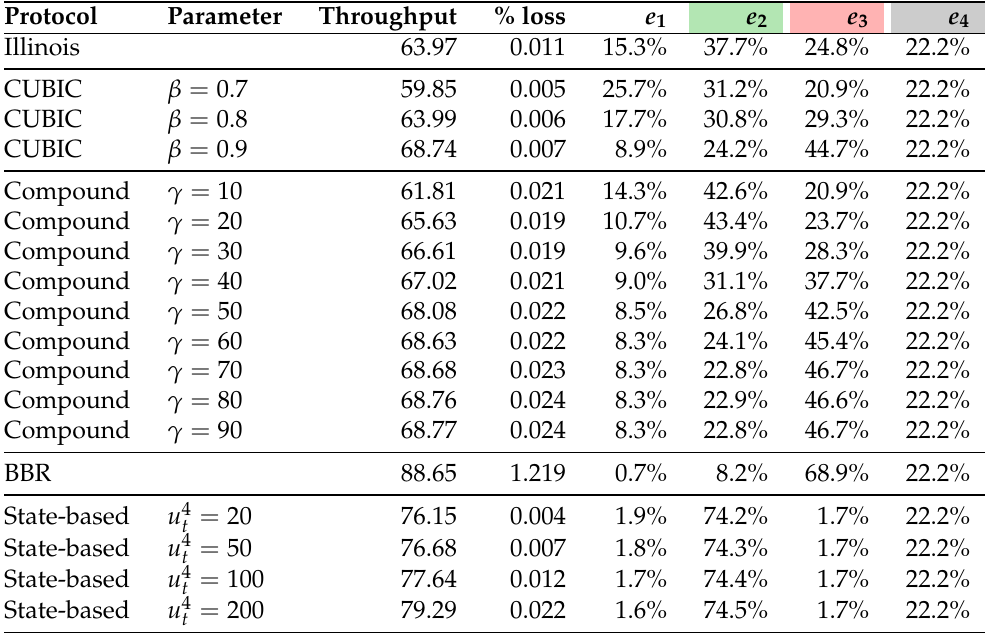
Table 1. Performance